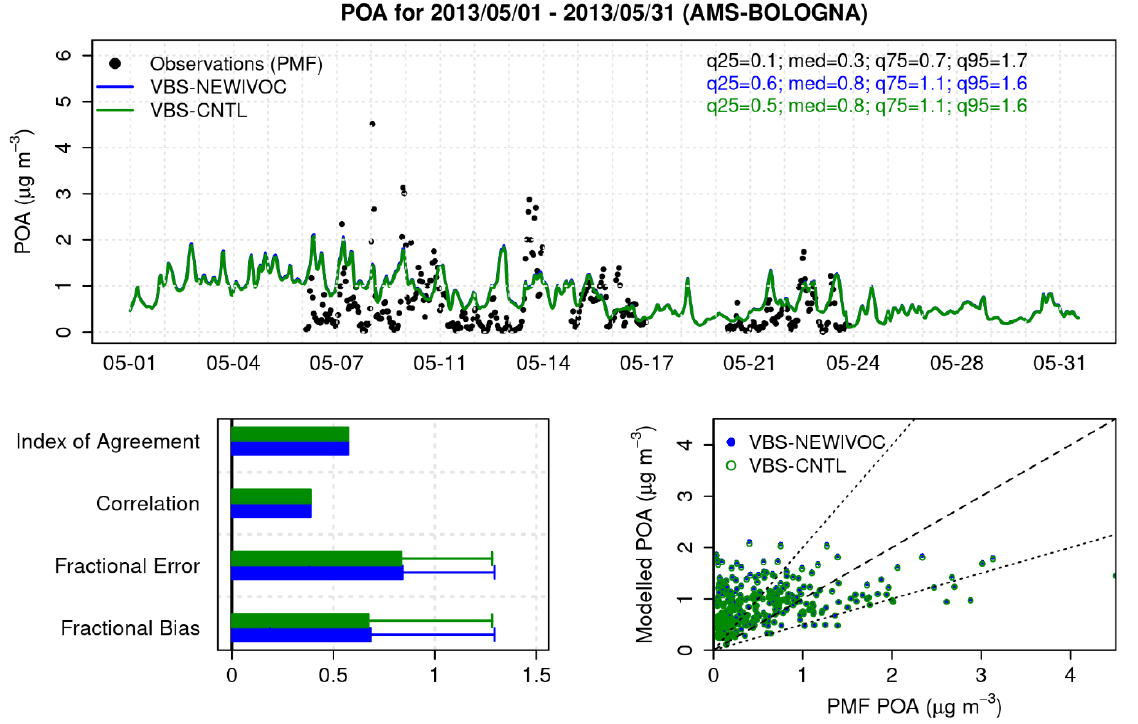
Figure 10. Comparison among modeled and observed (PMF results, black) POA concentrations in May 2013 at the Bologna site: VBS base scheme (VBS-CNTL, green) and VBS scheme with new parameterizations for IVOC emissions (VBS-NEWIVOC, blue).